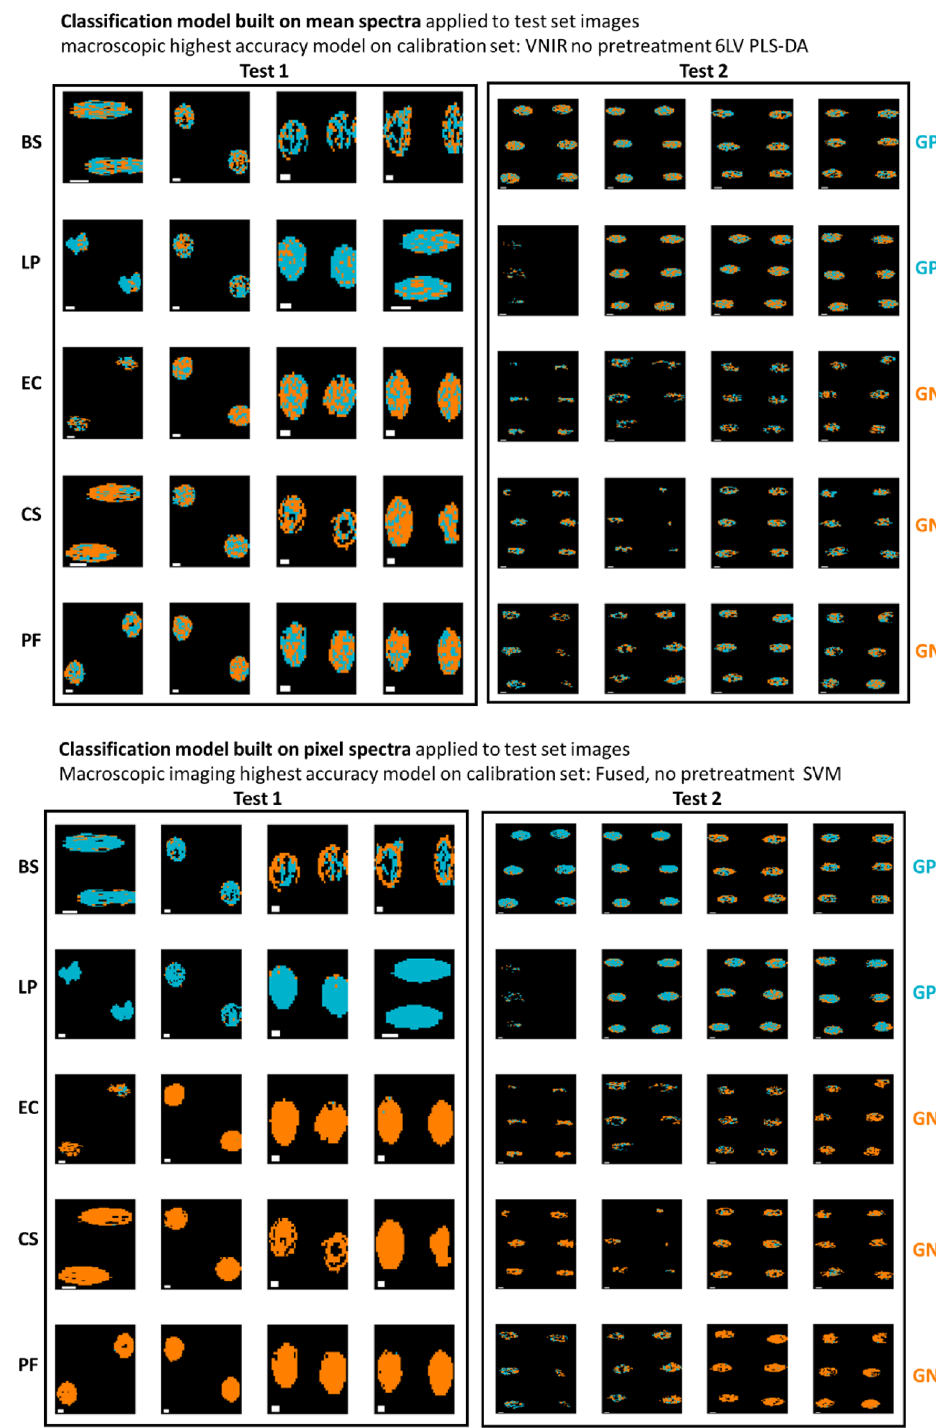
Figure 5. Classification maps for samples in the test set (reps 6, 9, 12, and 16) obtained from the best mean and pixel-level VNIR/SWIR models for GP/GN classification. Pixels classified as GP/GN are shown in blue or orange respectively. Each replicate has two drops. BS: Bacillus subtilis ; LP: Lactobacillus plantarum ; EC: Escherichia coli , CS: Cronobacter sakazakii ; PF: Pseudomonas fluorescens. White scalebar indicates 1 mm (width) × 0.25 mm